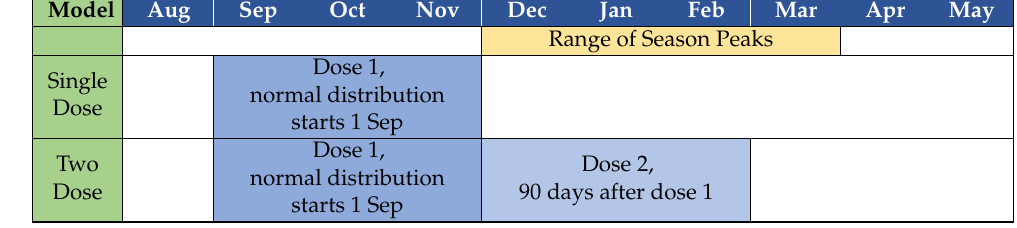
Table 1. Study Design: Two dose vaccination strategies. 90-day: Single dose: Doses occur over 90 days beginning 1 September following a normal distribution. Two Dose: Doses occur over 90 days beginning 1 September following a normal distribution. The second dose occurs 90 days after the first. Full vaccine effectiveness begins two weeks after dose 1, is sustained for two weeks, then wanes daily one month after dose 1. Waning from dose 1 stops for two weeks after dose 2. Full vaccine effectiveness begins again two weeks after dose 2, then wanes daily one month after dose 2. Model Aug Sep Oct